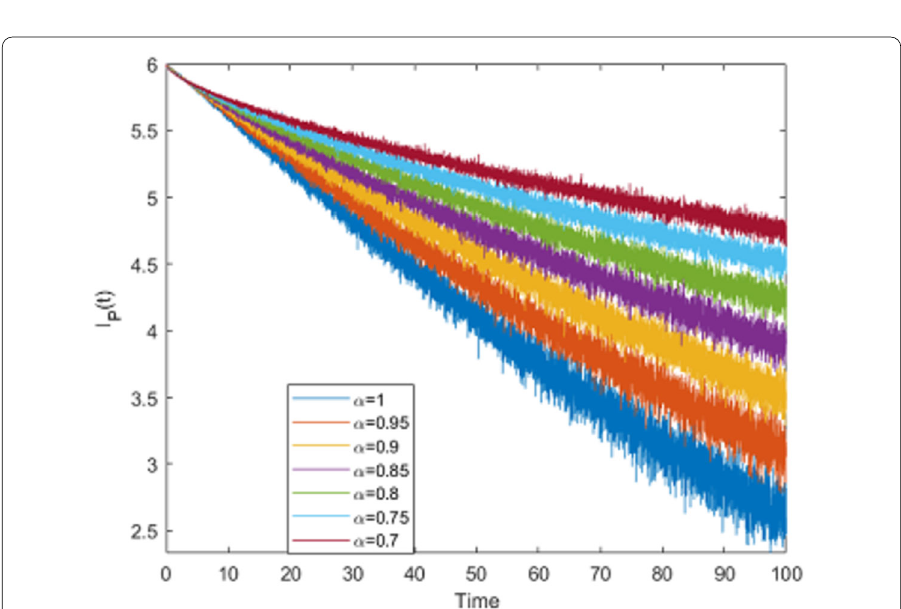
Figure 16 The class of researchers affected but still with positive opinion for σ 3 = 0.00032